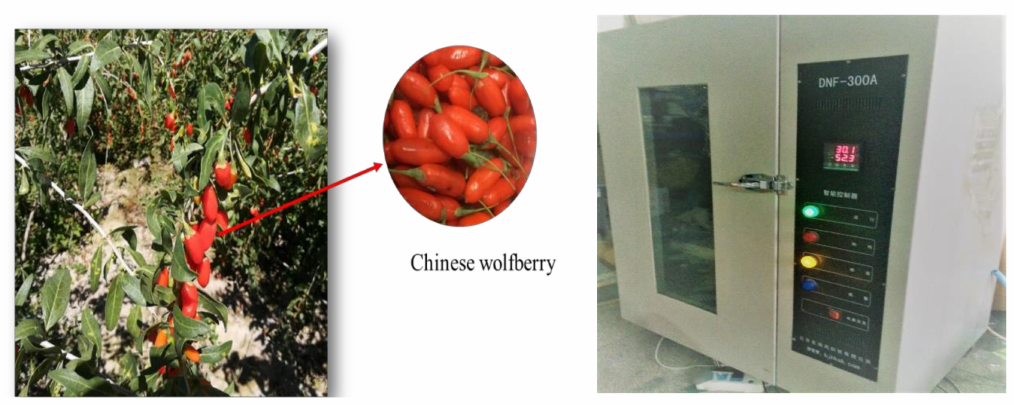
Figure 2. Photos of wolfberry (left) and thermostat-humidistat oven